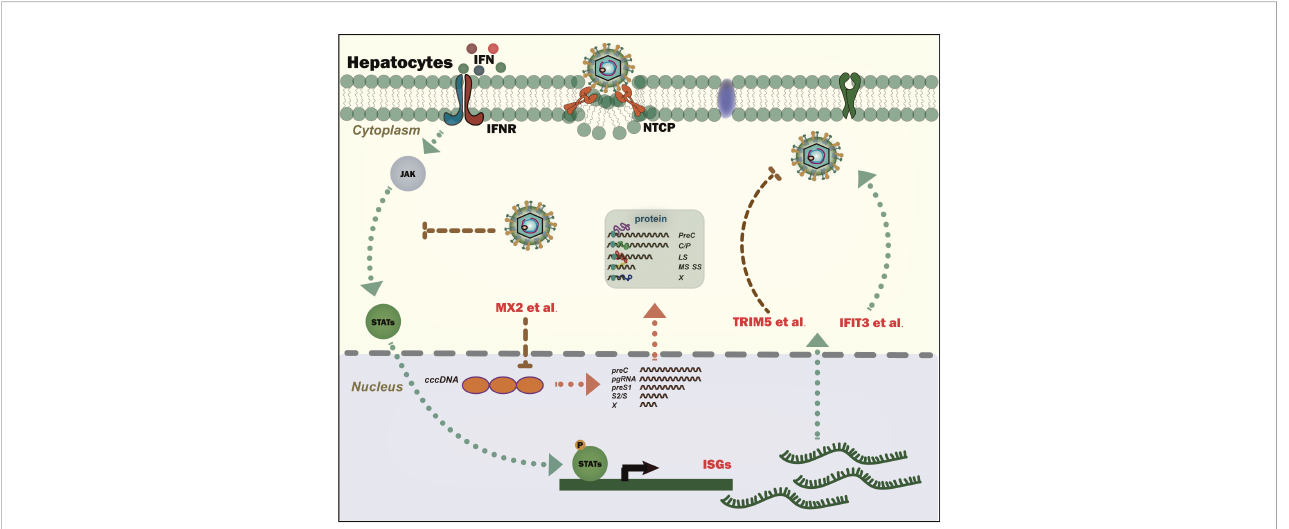
FIGURE 1 Model depicting the dual role of interferon in regulating the replication of the hepatitis B virus. Interferon stimulation results in the production of ISGs. Most ISGs play a positive role in regulating HBV replication; however, contrarily, some of them also promote HBV replication. ISGs (MX2 et al.) could reduce the HBV template cccDNA. Interferon signaling pathways are also inhibited by HBV proteins like